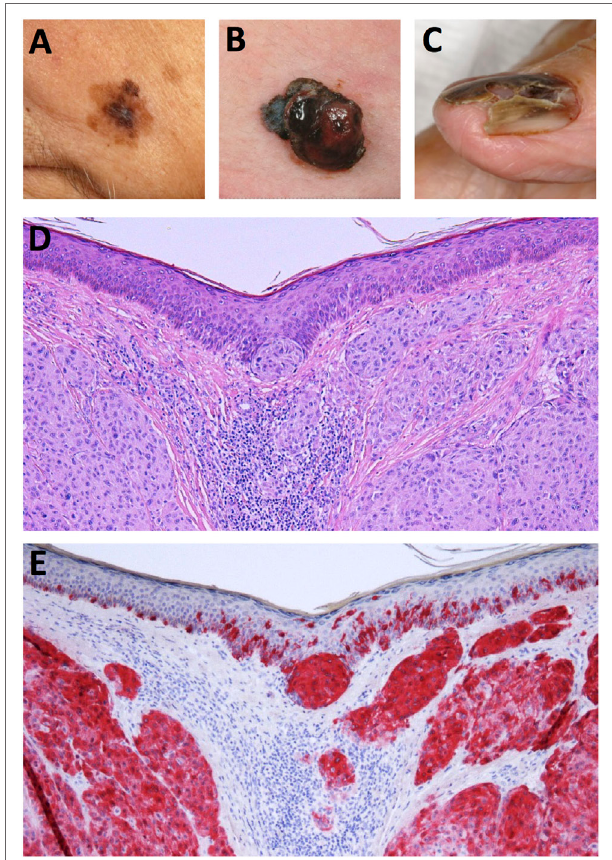
FiguRe 1 | Clinical and histological presentation of melanoma. (A) Superficial spreading melanoma (SSM), (B) nodular melanoma (NM), (C) acrolentiginous melanoma (ALM), (D) H&E stain of NM depicting asymmetrical nodular tumor infiltrates in the upper dermis. Nests of atypical cells are visible in the dermis and at the dermoepidermal junction. (e) Immunohistochemical staining for Melan-A reveals red stained atypical tumor cells in the dermis and epidermis (Images courtesy of